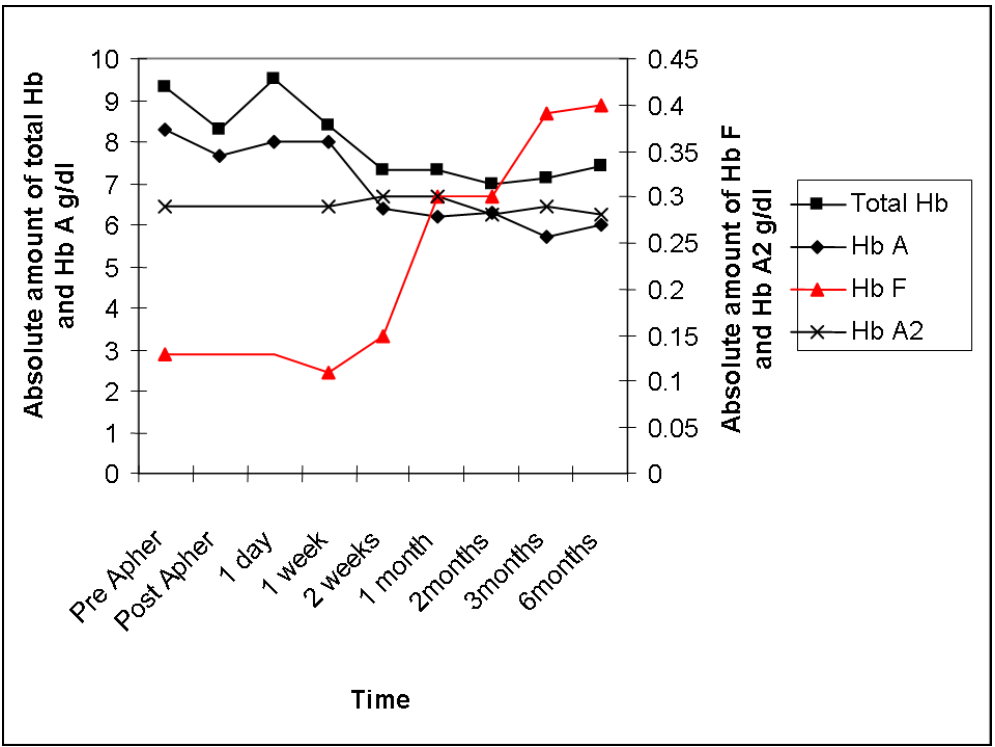
FIGURE 4. Mean hemoglobin type change at 1 day, 1, 2 weeks, 1, 2, 3, and 6 months following infusion of the RSC into patients with beta-thalassemia when compared to baseline. At pre- (time point denoted Pre Apher) and just after apheresis (time point denoted Post Apher), patients received recent transfusions. From thereon, transfusion threshold was set at 7 g/dl.